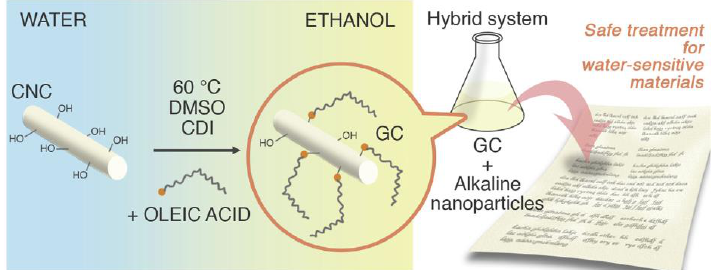
Figure 12. Schematization of conservation proposal by Xu et al. Reproduced with permission [100]. Copyright © 2020, Elsevier.